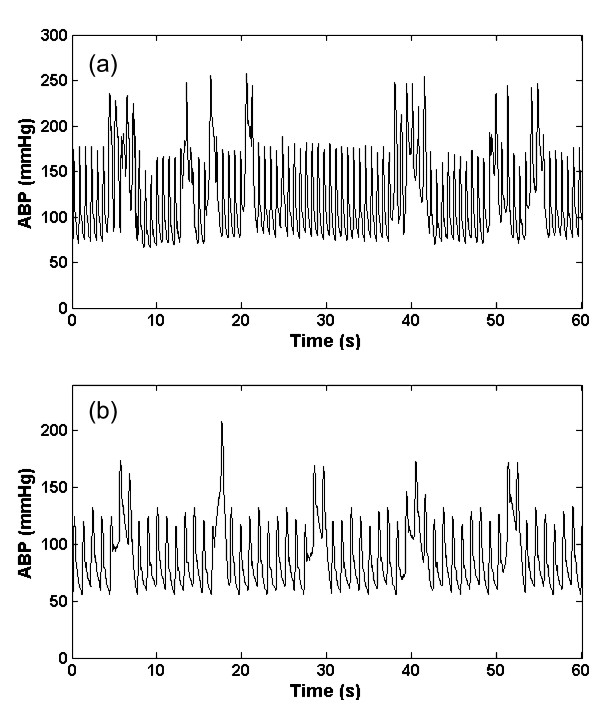
Artifact 6, (aimp); Real (a) and Simulated (b) ABP impulse artefact using an adjustable sinc function (Eq. (4)).